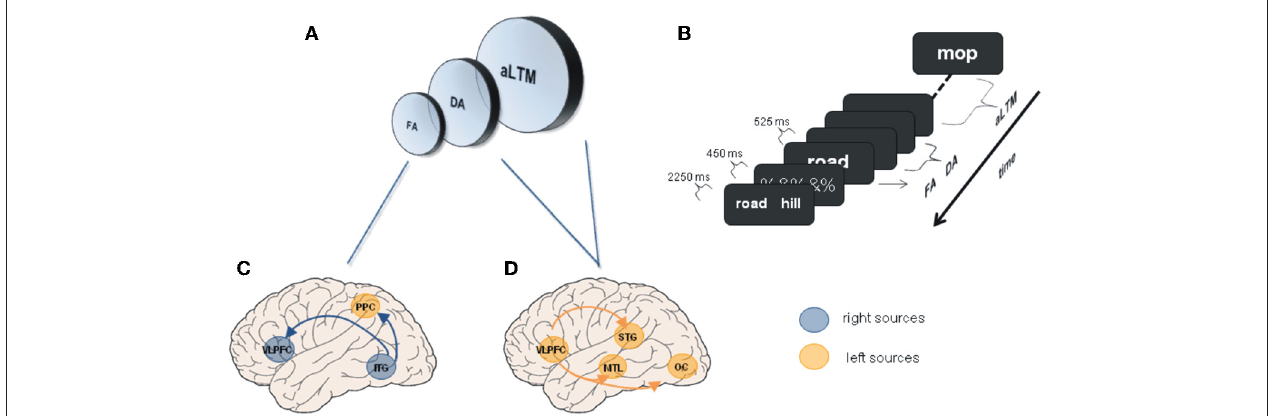
FIGURE 1 | Unitary memory models and associated functional connectivity networks. (A) Unitary memory models posit that perception, WM and LTM do not differ in the underlying neural substrates, but in the state of information representations. Accordingly, two or three states are proposed: a focused of attention (FA); a region of direct access (DA); and other information that is hypothesized to be an activated portion of LTM (aLTM). The last two states are considered to be undistinguishable by some authors leading to two states models (Oberauer, 2002; McElree, 2006; Lustig et al., 2009; Öztekin et al., 2010; Nee and Jonides, 2011). (B) Serial position task (SP) of 12 items used to explore differences among the three